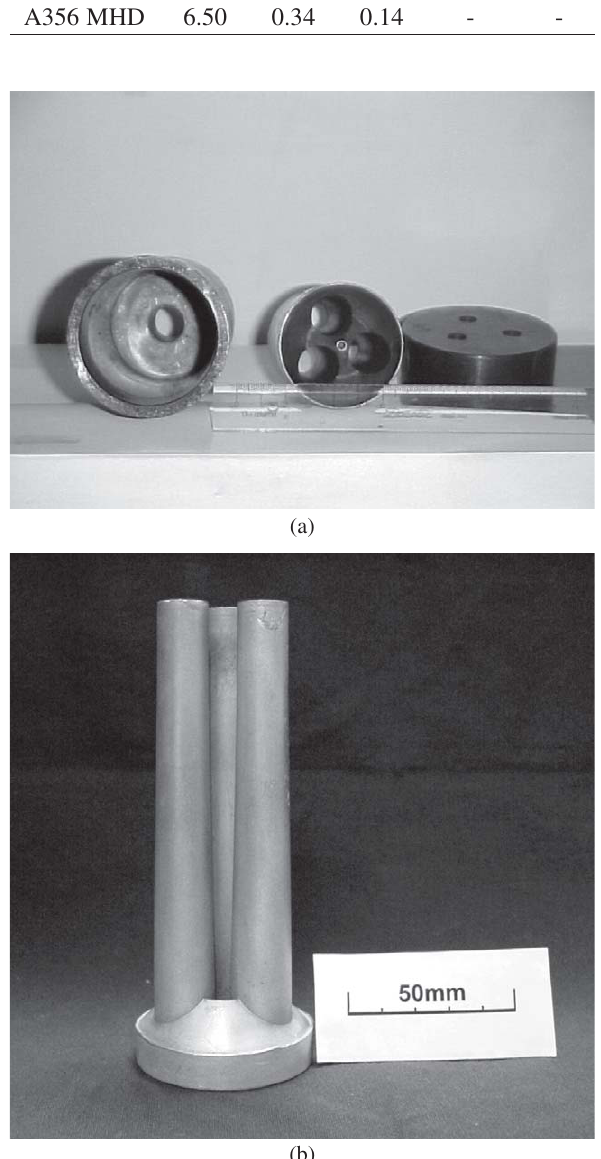
Figure 1. Components of the thixoextrusion die and a typical three rods